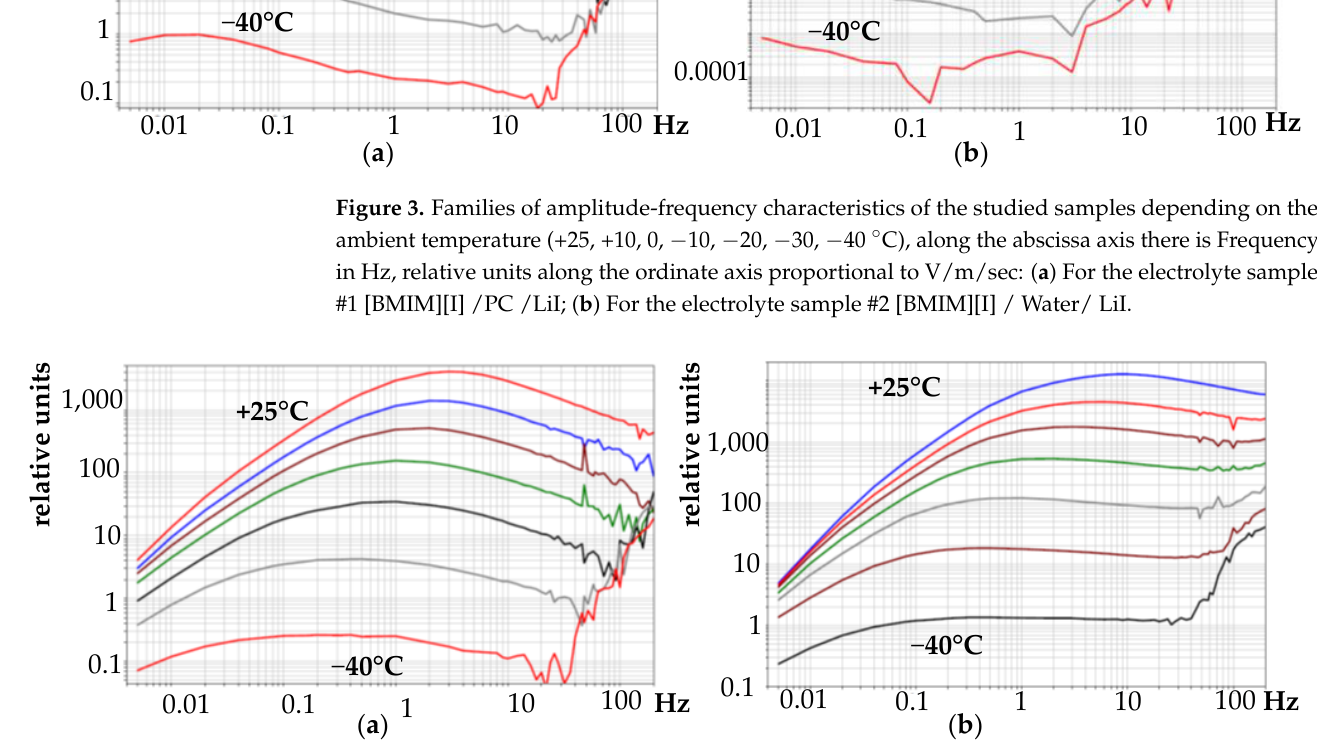
( a ) ( b ) Figure 5. Families of amplitude-frequency characteristics of the studied samples depending on the ambient temperature (+25, +10, 0, −10, −20, −30, −40 °С ), along the abscissa axis there is Frequency in Hz, relative units along the ordinate axis proportional to V/m/sec: ( a ) For the electrolyte sample #5 Water/LiI/PC, J 2 = 0.01 mol/liter; (b) For the electrolyte sample #6: Water/KI/PC, J 2 = 0.05 mol/liter.